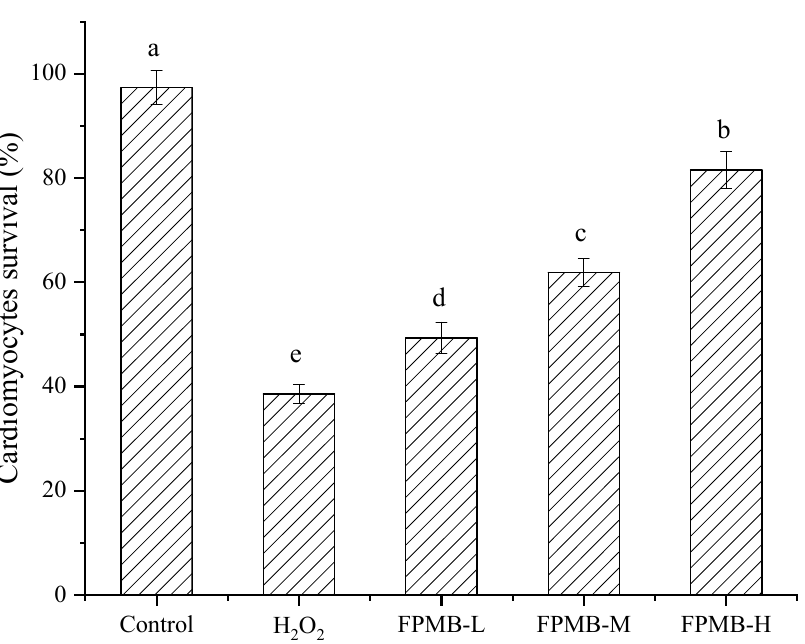
Figure 2. Effect of FPMB on the cardiomyocyte survival for mice injured by H 2 O 2 . Different lowercase letters (a, b, c, d, e) express significant differences ( p < 0.05).